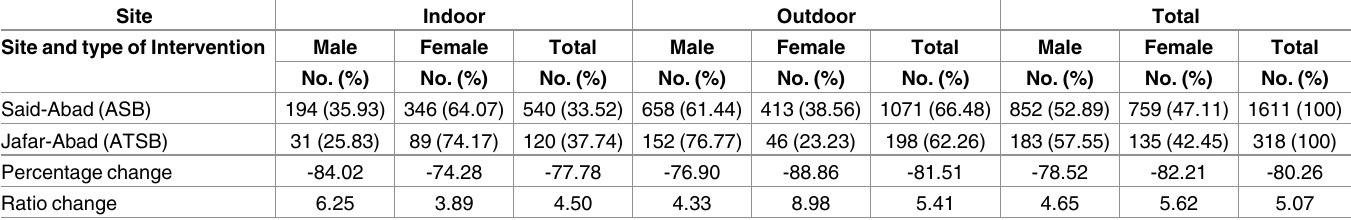
Based on the results in according to Table 3, the frequency of P . papatasi collected by indoors and outdoors sticky traps in Jafar-Abad (plants, bushes, and shrubs sprayed with ATSB), showed a decline in comparison to Said-Abad (plants, bushes, and shrubs sprayed with ASB). In fact, in Jafar-Abad, the percentage change in sand flies population reached to -77.78%, -81.51%, and -80.26% indoors, outdoors, and in total, respectively (Table 3). In addi- tion, the frequency of P . papatasi collected by light traps considerably reduced (Table 4). According to statistical tests, in the site with ATSB sprayed on vegetation, compared with the ASB sprayed site, not only the ratio change of P . papatasi density reduced more than 5 times (Tables 3 and 4), this reduction was also statistically significant (p = 0.029). Also, the graphs of monthly activity of P . papatasi collected from treated barrier fences and treated vegetation show the reduction of their density in the sites where sand flies were exposed to ATSB (Fig 2 and Fig 3). In the treatment village, after the setup of the ATBS-treated barrier fences, the Ratio changes Percentage changes and of reduction in the initial densities of P . papatasi was 8.79 (-88.68%), 7.85 (-87.27%), and 8.28 (-87.93%) times indoors, outdoors and in total (Table 5). Table 1 demonstrates the percentage ch- ange in the P . papatasi population in the village following the barrier fences. Compared to pre-treatment numbers of the previous year, there was a considerable reduction in the P . papatasi density in post–ATSB application as barrier fences in treatment site (-87.93%) (Table 5). The comparison of P . papatasi frequency indoors and outdoors in Kooh-Sefid and Faraj- Abad (ATSB and ASB-treated barrier fences) using sticky traps showed that there was a con- siderable reduction in P . papatasi density with ATSB-treated barrier fences in the treatment site, compared to the control site where ASB were used (-69.94%). The Ratio change showed that the population of P . papatasi reduced more than 3 times (3.33 times) (Table 6). Moreover, the P . papatasi population in the treatment villages with ATSB treated barrier fences in comparison with ASB treated barrier fences decreased several times (Tables 6 & 7).